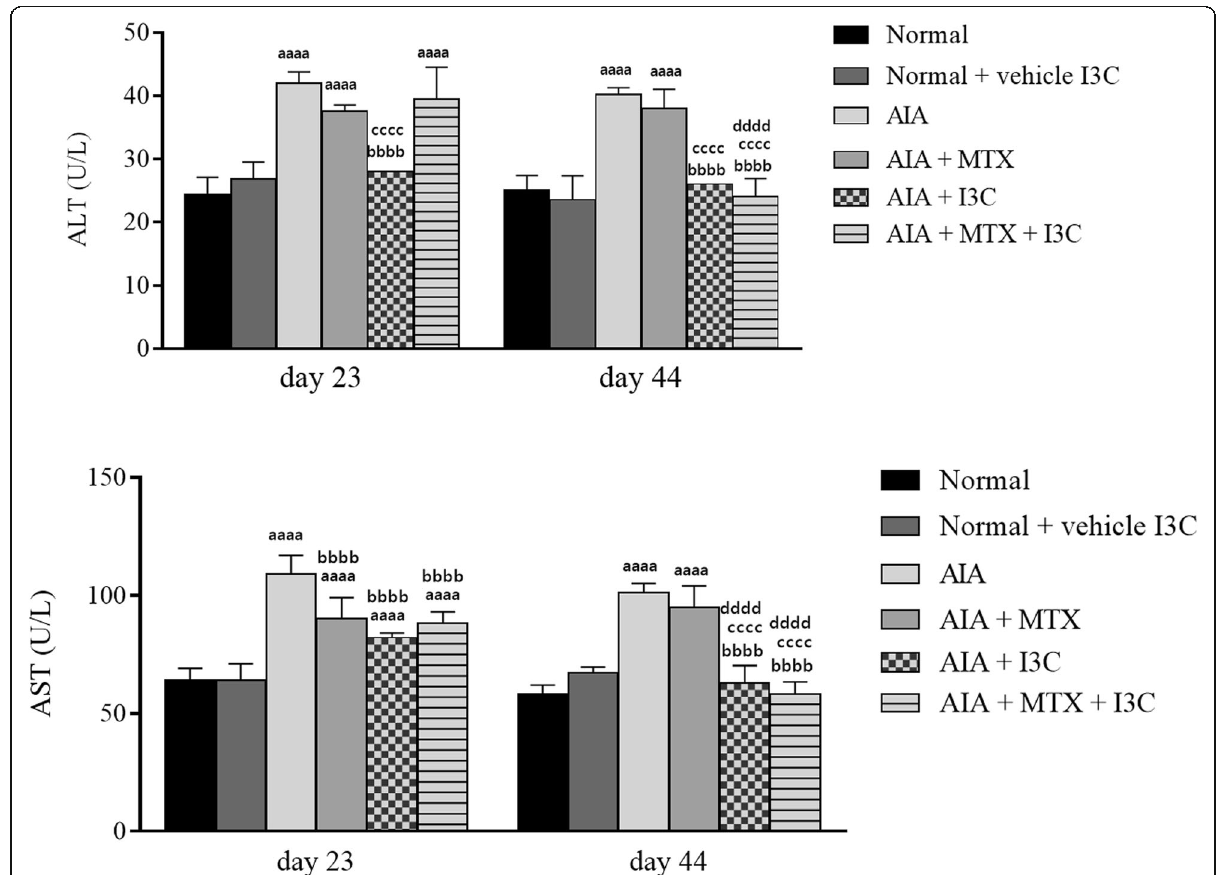
Fig. 5 Assessing effect of I3C on liver function enzymes on day 23 and day 44 ( n = 4). a Mean ALT values (U/L) in serum of rats. b, Mean AST values (U/L) in serum of rats. aaaa p < 0.0001 compared with the normal group receiving the vehicle (there was no statistical significant difference between the two normal groups), bbbb p < 0.0001 compared with arthritic non-treated model group (AIA), cccc p < 0.0001 compared with the positive control group (AIA+ MTX), dddd p < 0.0001 compared with day